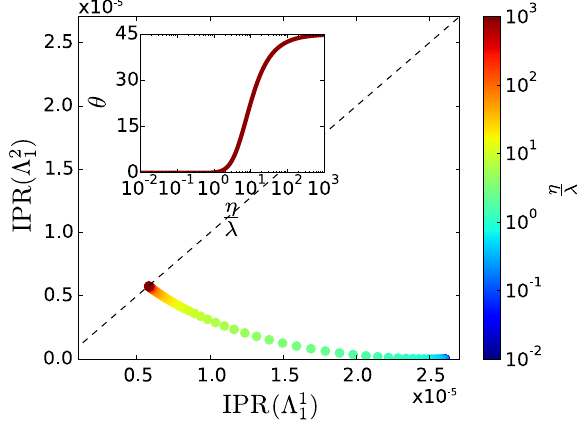
FIG. 5. Diagram of the contribution of each layer to the IPR ð Λ Þ for different values of the spreading ratio η = λ . The dashed line represents the case where both layers have the same contribution, i.e., a linewith slope one. In the inset, we show the angle θ between the vector composed of the contributions of each layer to the IPR ð Λ Þ , v ¼ ½ IPR ð Λ 1 1 Þ ; IPR ð Λ 2 1 Þ(cid:2) T , and the x axis. The multiplex network used here is composed of two Erdös-Rényi networks, both with n ¼ 5 × 10 4 — the first layer is h k i ¼ 16 [ ð Λ 1 1 Þ − 1 ≈